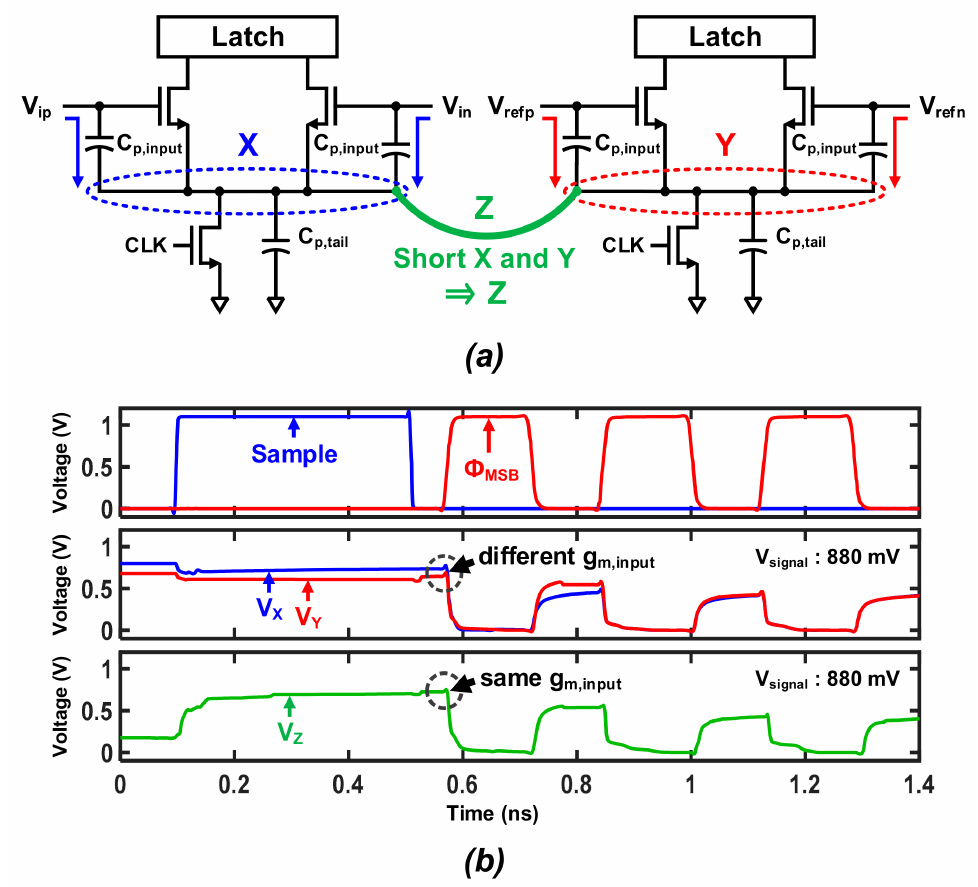
Figure 9. ( a ) Proposed tail-current-sharing comparator and ( b ) transient of tail node